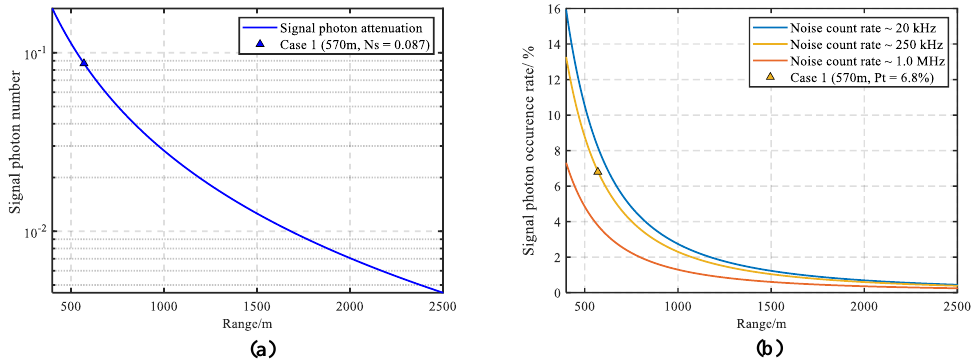
Figure 8. ( a ) Variation of the signal photon number with a range based on the estimated number in Case 1. ( b ) Variations of signal detection probability with the range at three different noise photon count rates of 20 kHz, 250 kHz, and 1 MHz, which correspond to the dark count rate of the detector, the solar background noise level of Case 1, and the condition when the sun shines almost directly on the receiving